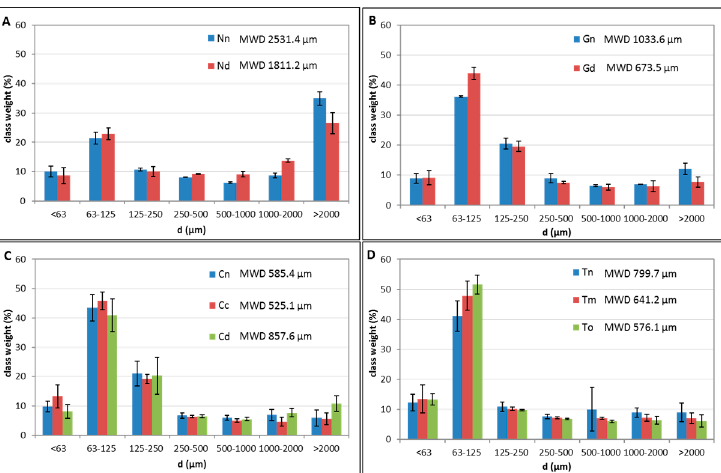
Figure 5. Aggregate size distribution (ASD) in the land use areas: ( A ) Natural soil before (Nn) and after (Nd) artificial (short-term) disturbance. ( B) Grazing area before (Gn) and after (Gd) artificial (short-term) disturbance. ( C) Conventional agriculture practice with no-till (Cn), disk-tillage (Cd), and cultivator-tillage (Cc). ( D) Traditional practice with no grazing (Tn), medium grazing (Tm), and over-grazing (To). The mean weight diameter (MWD) for each ASD is presented at the upper right corner. (Data were taken from Swet and Katra, 2016 [11], and Katra et al., 2016 [3]). The PM10 concentrations that were measured in the disturbed soils are presented in Figure 6. In all land uses, the PM10 concentrations by soil erosion were increased in response to the short-term